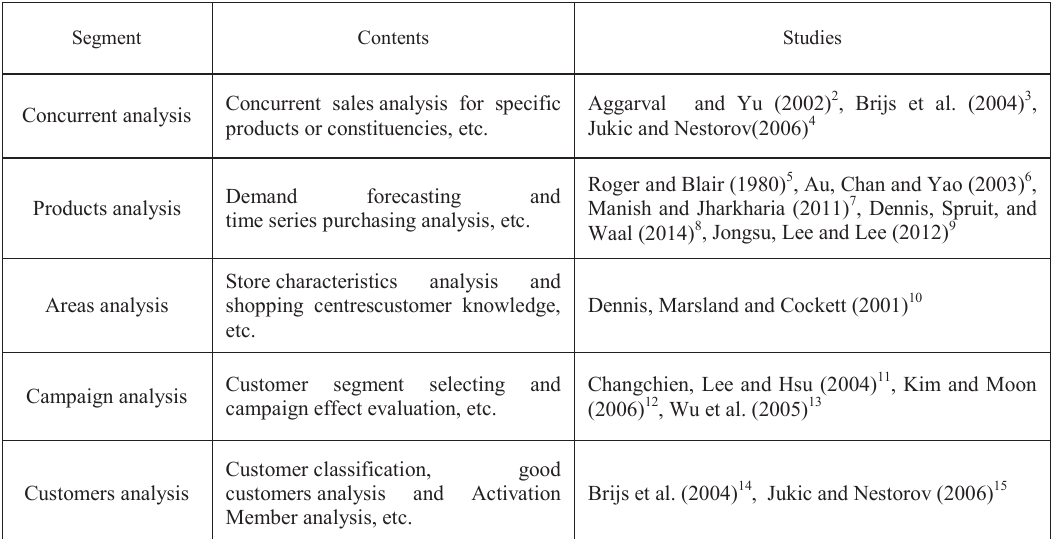
Table 1. Studies concerned with marketing